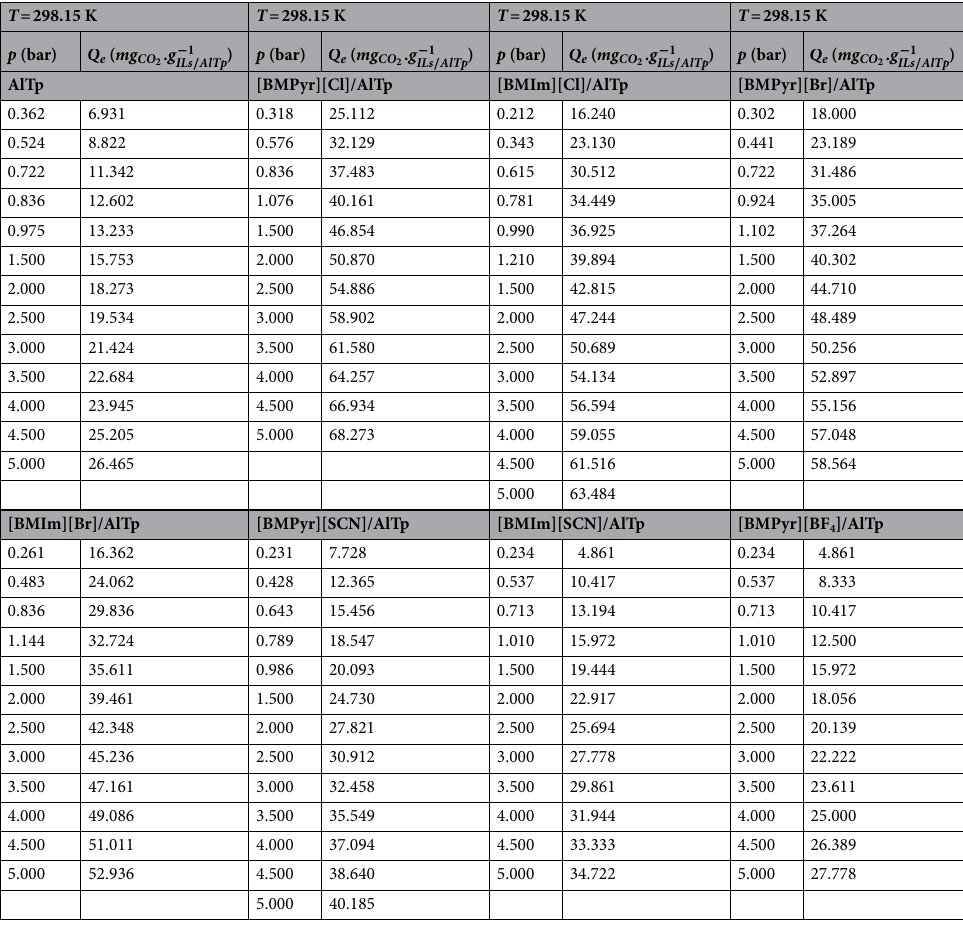
1 ILs / AlTp ) of ILs/AlTp at 298.15 K and pressures up to 5 bar.